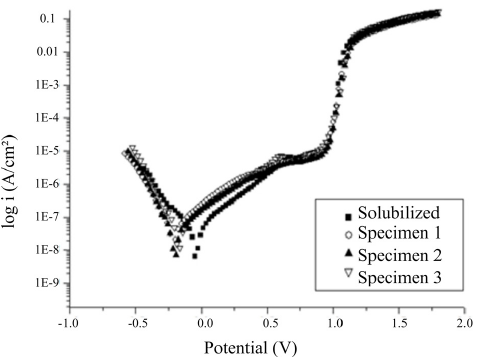
Figure 6. Values of corrosion potential obtained after linear polarization in 3.5% NaCl solution. The solubilized specimen has a higher value, although not significant.